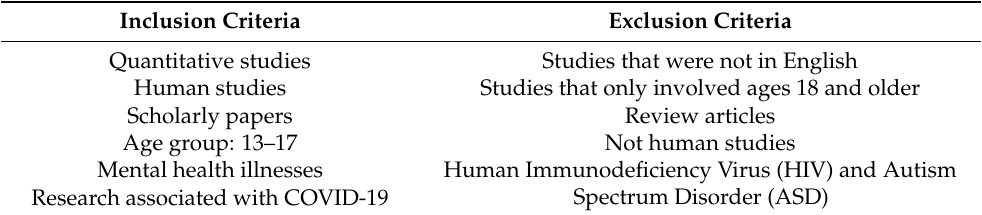
Table 1. Inclusion and Exclusion Criteria. Inclusion Criteria